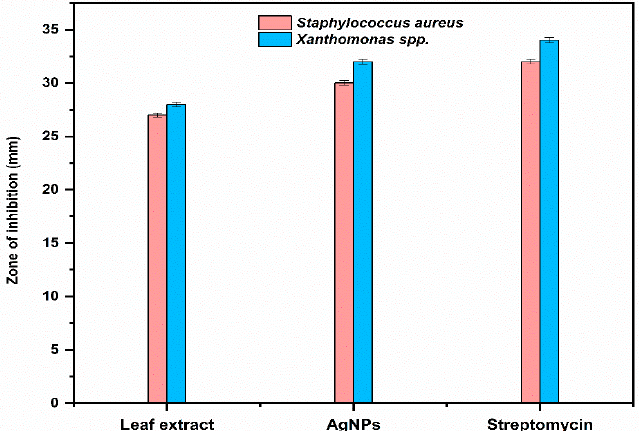
Figure 9. Comparison of antibacterial activity of leaf extract and the biosynthesized AgNPs. The antifungal activity of Trigonella foenum-graecum L. aqueous leaf extract and the biosynthesized AgNPs was tested using the well diffusion method against Macrophomina phaseolina and Fusarium oxysporum and was compared with control. Nystatin and distilled water were employed as the positive and negative control, respectively. The leaf extract (1000 ppm), AgNPs (1000 ppm), and Nystatin (100 ppm) showed ZOIs of 22 ± 0.16 mm, 23 ± 0.17, and 33 ± 0.22 mm, respectively, against Macrophomina phaseolina (Figure